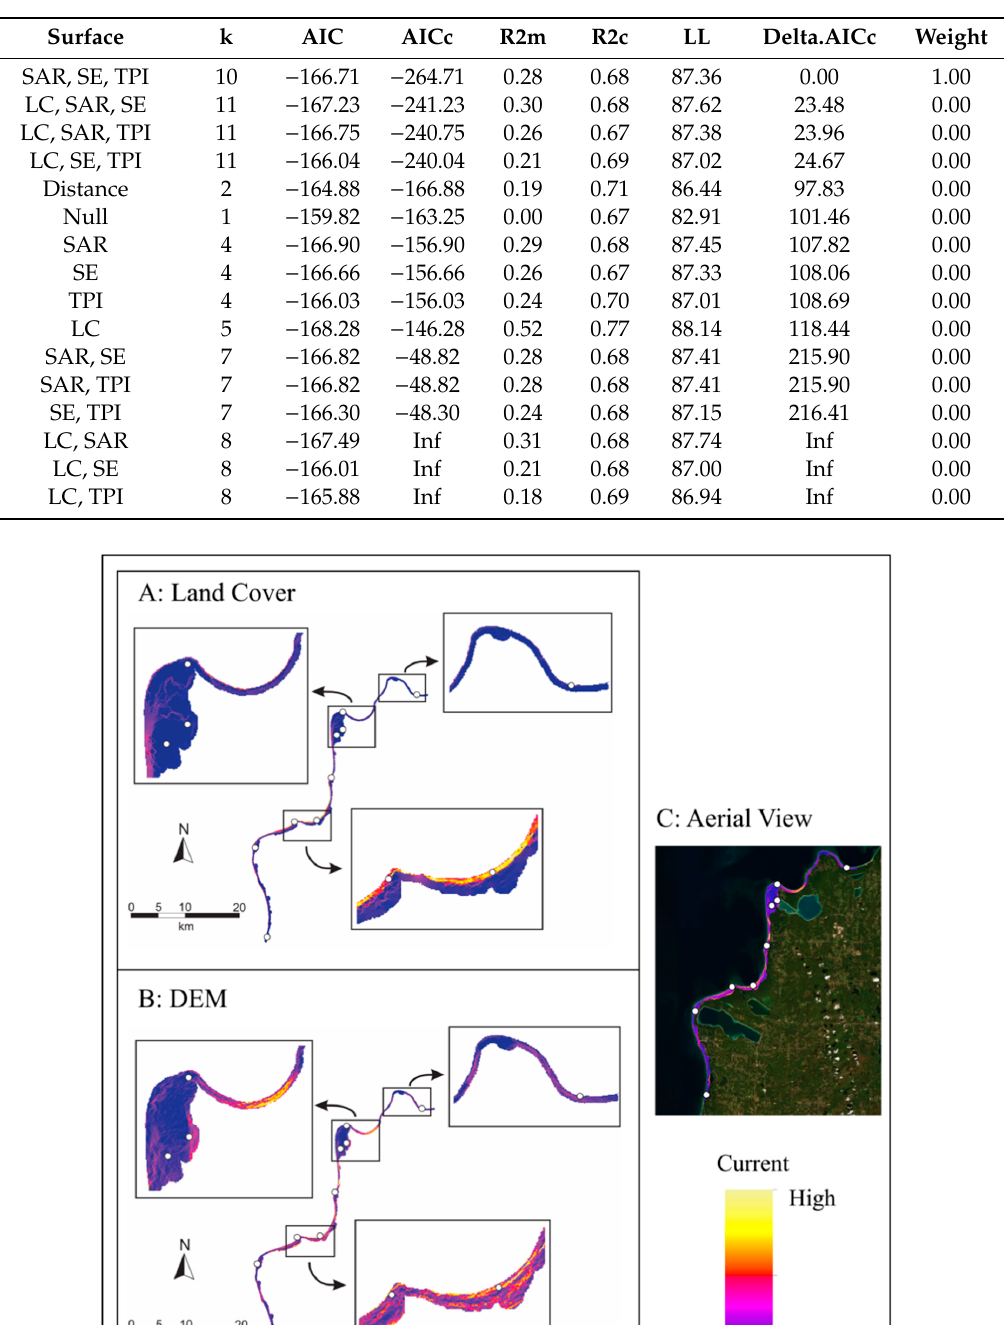
Table 3. Model ranking from ResistanceGA for land cover (LC), surface area ratio (SAR), site exposure (SE), and topographic position index (TPI).